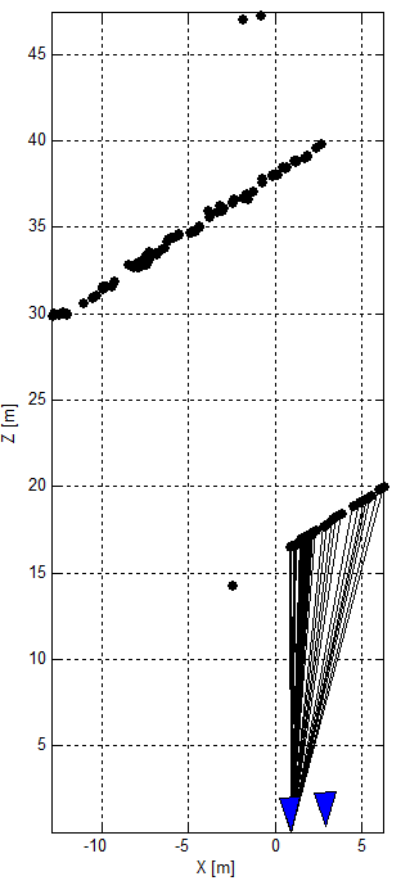
Figure 5: Results of the bundle adjustment, drawn in nadir view. Two of the four camera poses denoted as triangles (projected blue pyramids) can be seen from this aspect. 3D points are denoted by dots, the straight line segments refer to the laser observations measured at the system’s first